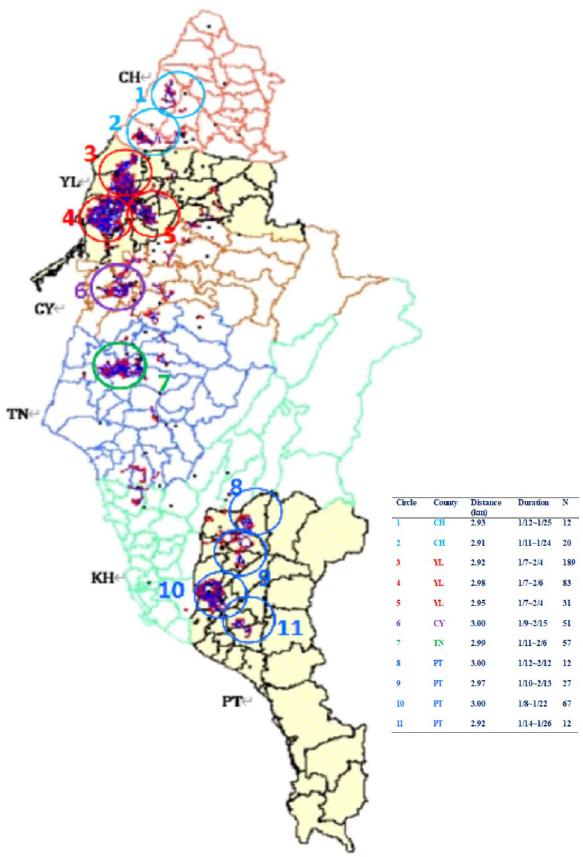
Figure 3. The partition of 6 counties (southwestern Taiwan) formed by Knox statistic under optimal space– time cut-off; 11 major clusters are identified. For each circle, which represents a cluster, the distance (reported in the table) is defined as the maximum distance (kilometer, km) among all of the outbreak pairs. Duration denotes the dates between the first and the last outbreak farms in the circle, and N is the number of outbreaks in that